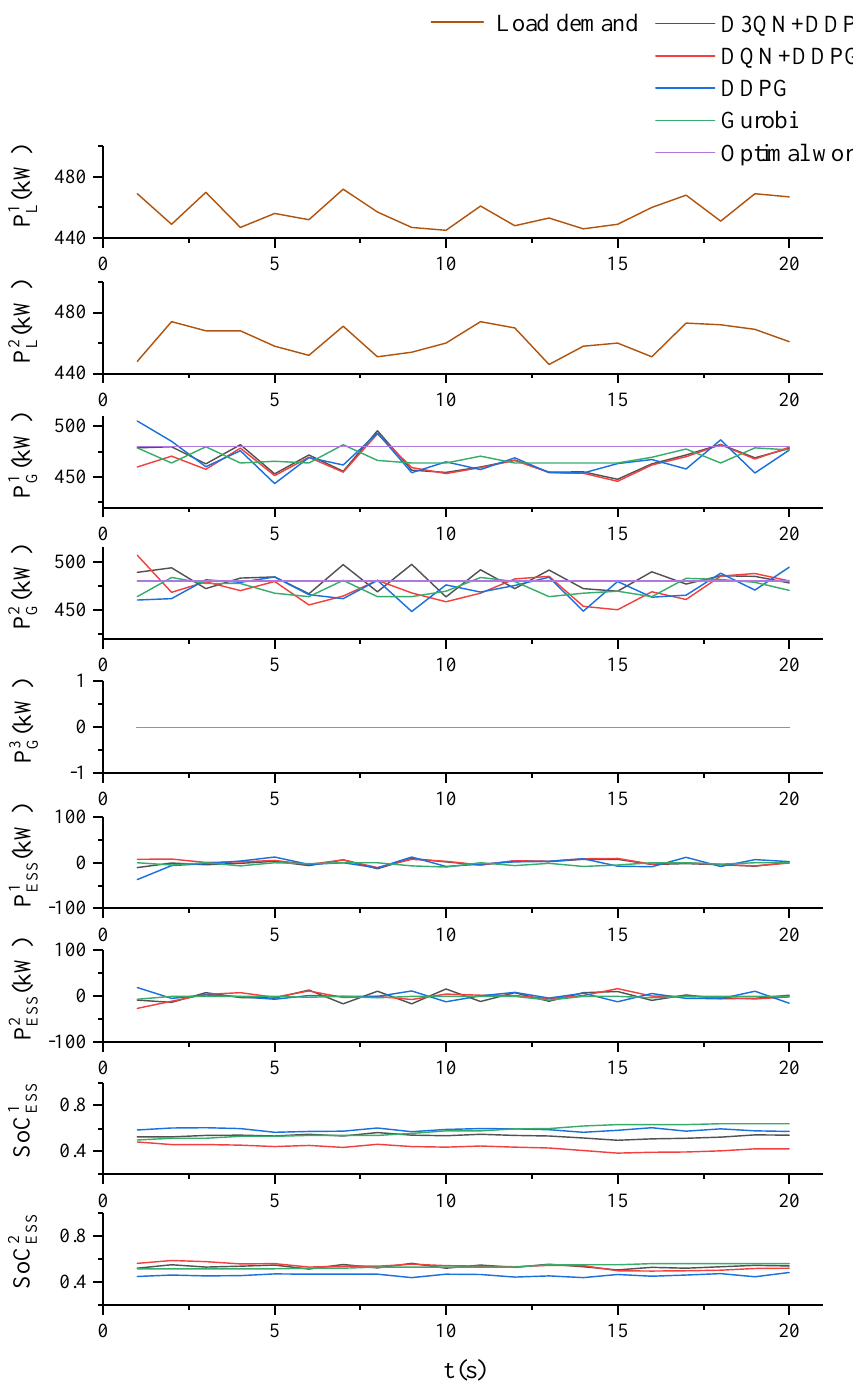
Figure 7. Condition 1 (main generators are normal). Condition 2: Main generator 1 is damaged (t = 8 s), and the main generator 2 is normal, as shown in Figure 8. When the main generator 1 fails, according to the principle of load shedding and priority of generators and buses, the main generator 2 should provide all the power and the load is shed in priority at this time. However, in consideration of minimizing load shedding, the APU starts to work to compensate for the impact on the power supply due to the damage to main generator